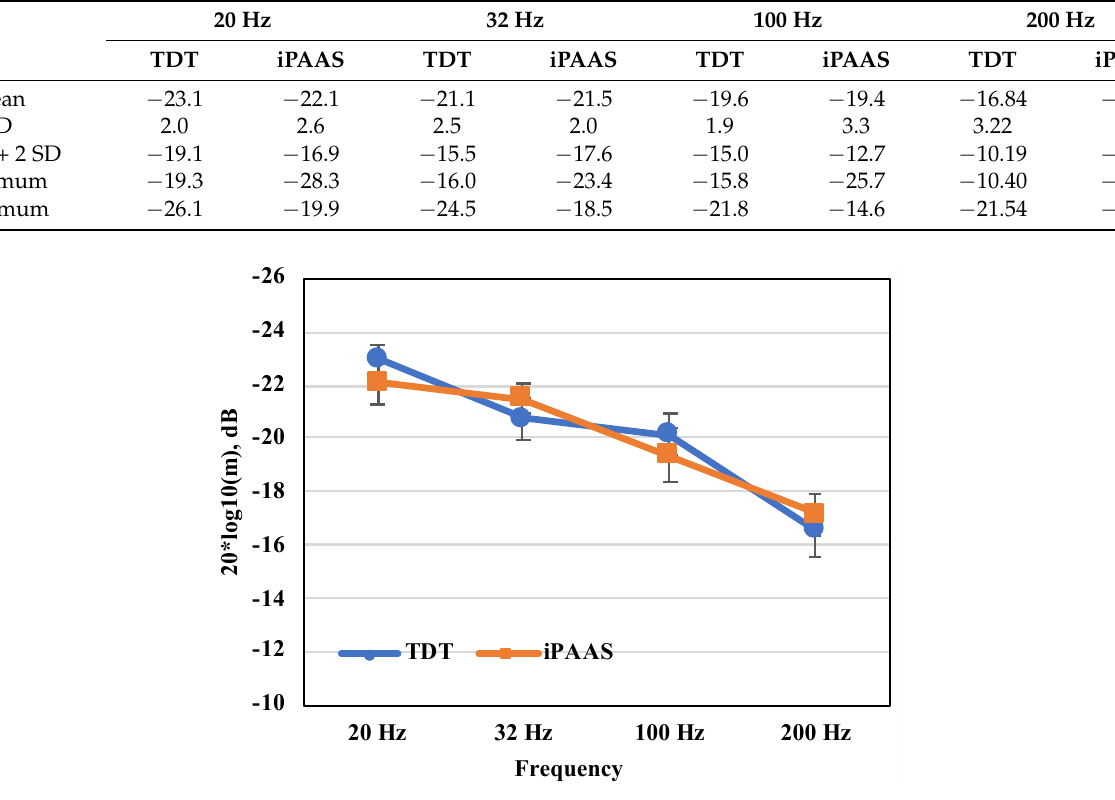
Table 2. Descriptive results for the AMD thresholds (given in dB) for the laboratory-based system (TDT) and iPAAS system.